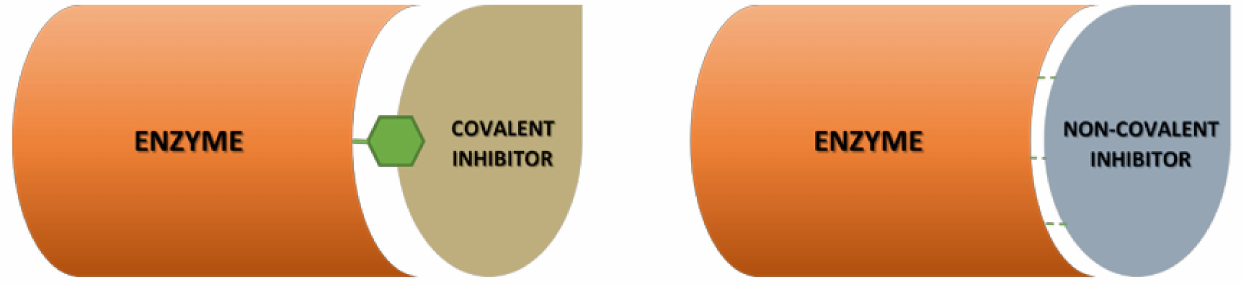
Figure 2. Illustration of two binding pathways in major inhibition mechanisms: covalent (left) and non-covalent (right)